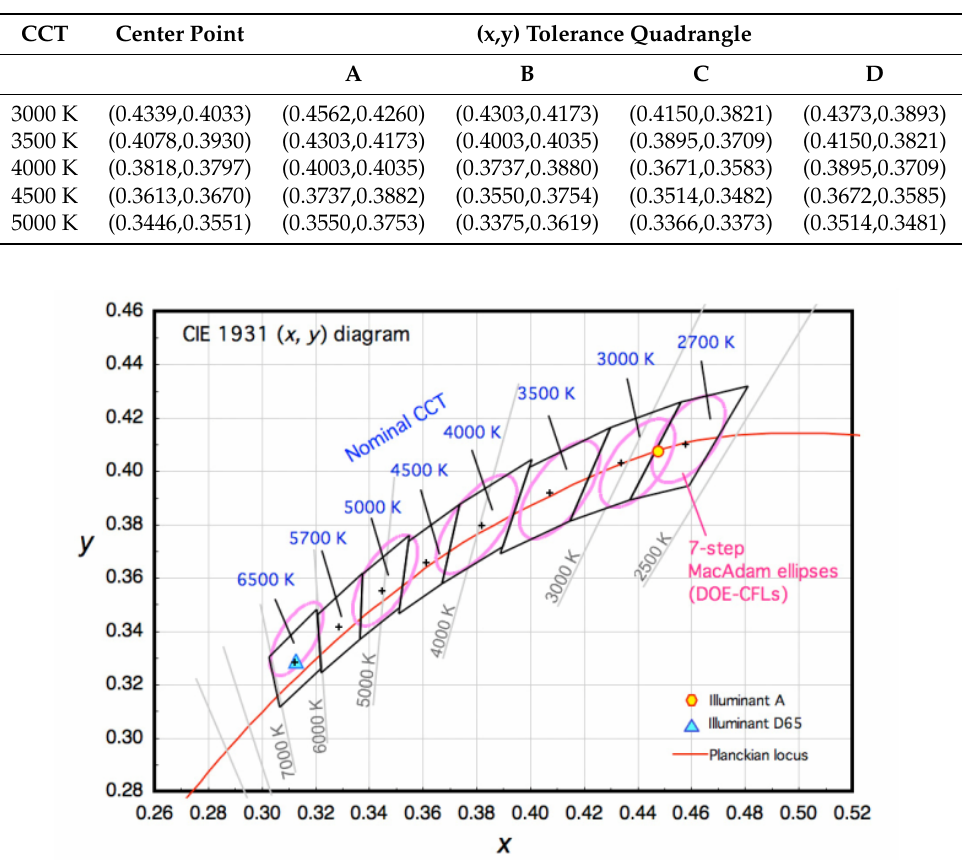
Table 1. Coordinate of the four corners for the quadrangle constraint at different correlated color temperatures (CCTs).